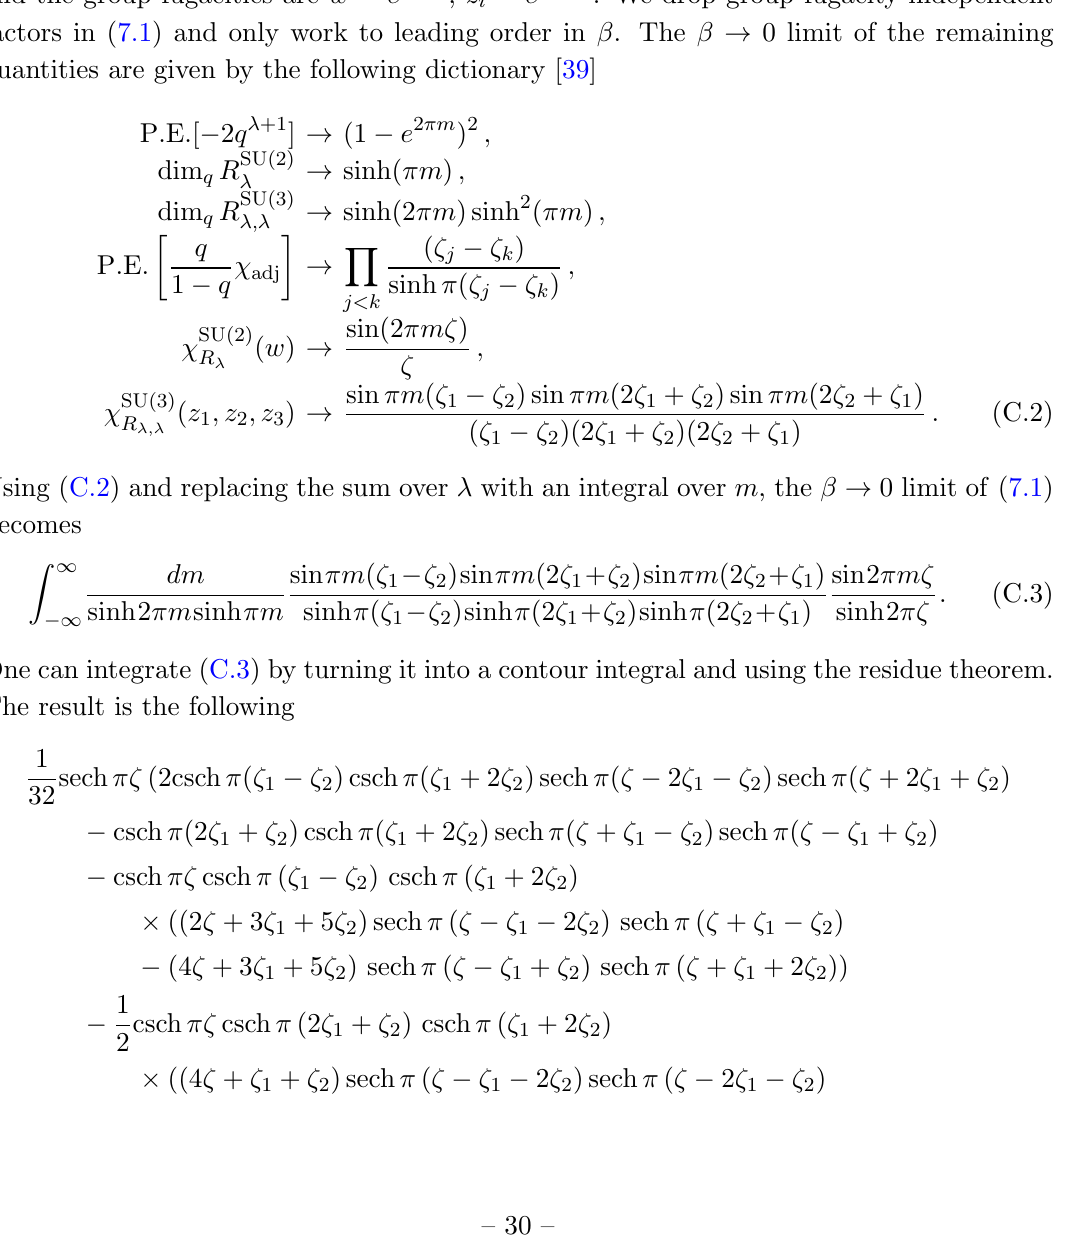
theory (it is mirror to the 3 T 3 , 2